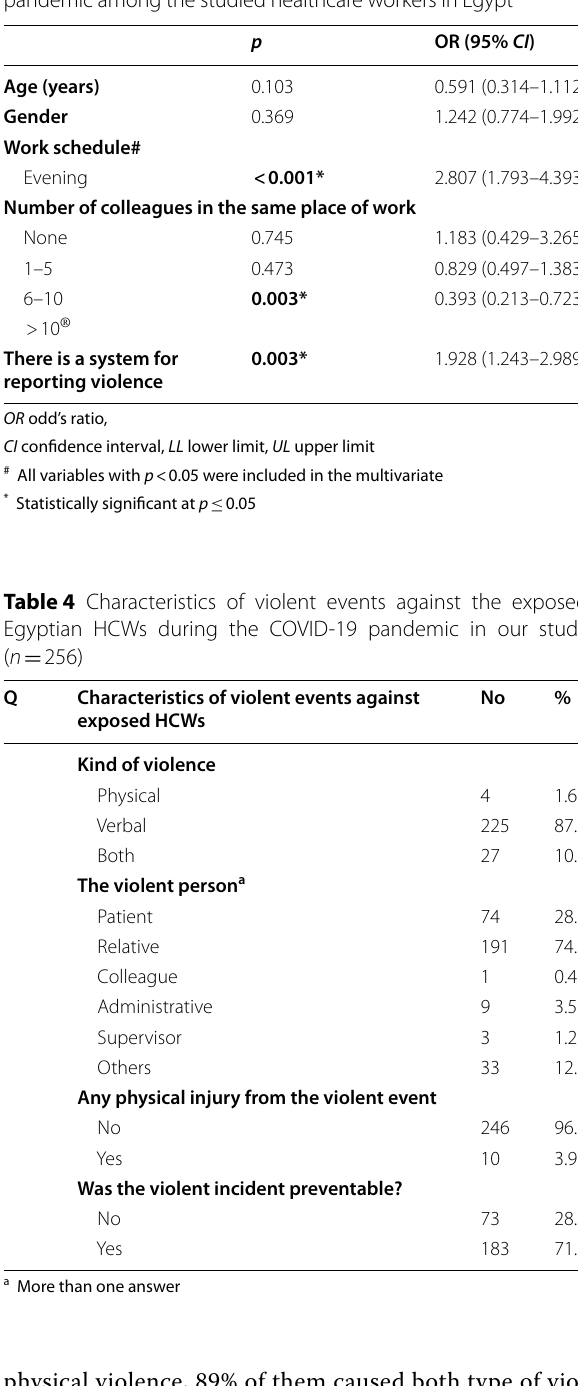
Table 3 Multivariate logistic regression analysis for the predictors affecting suffering from violence in context with the COVID‑19 pandemic among the studied healthcare workers in Egypt